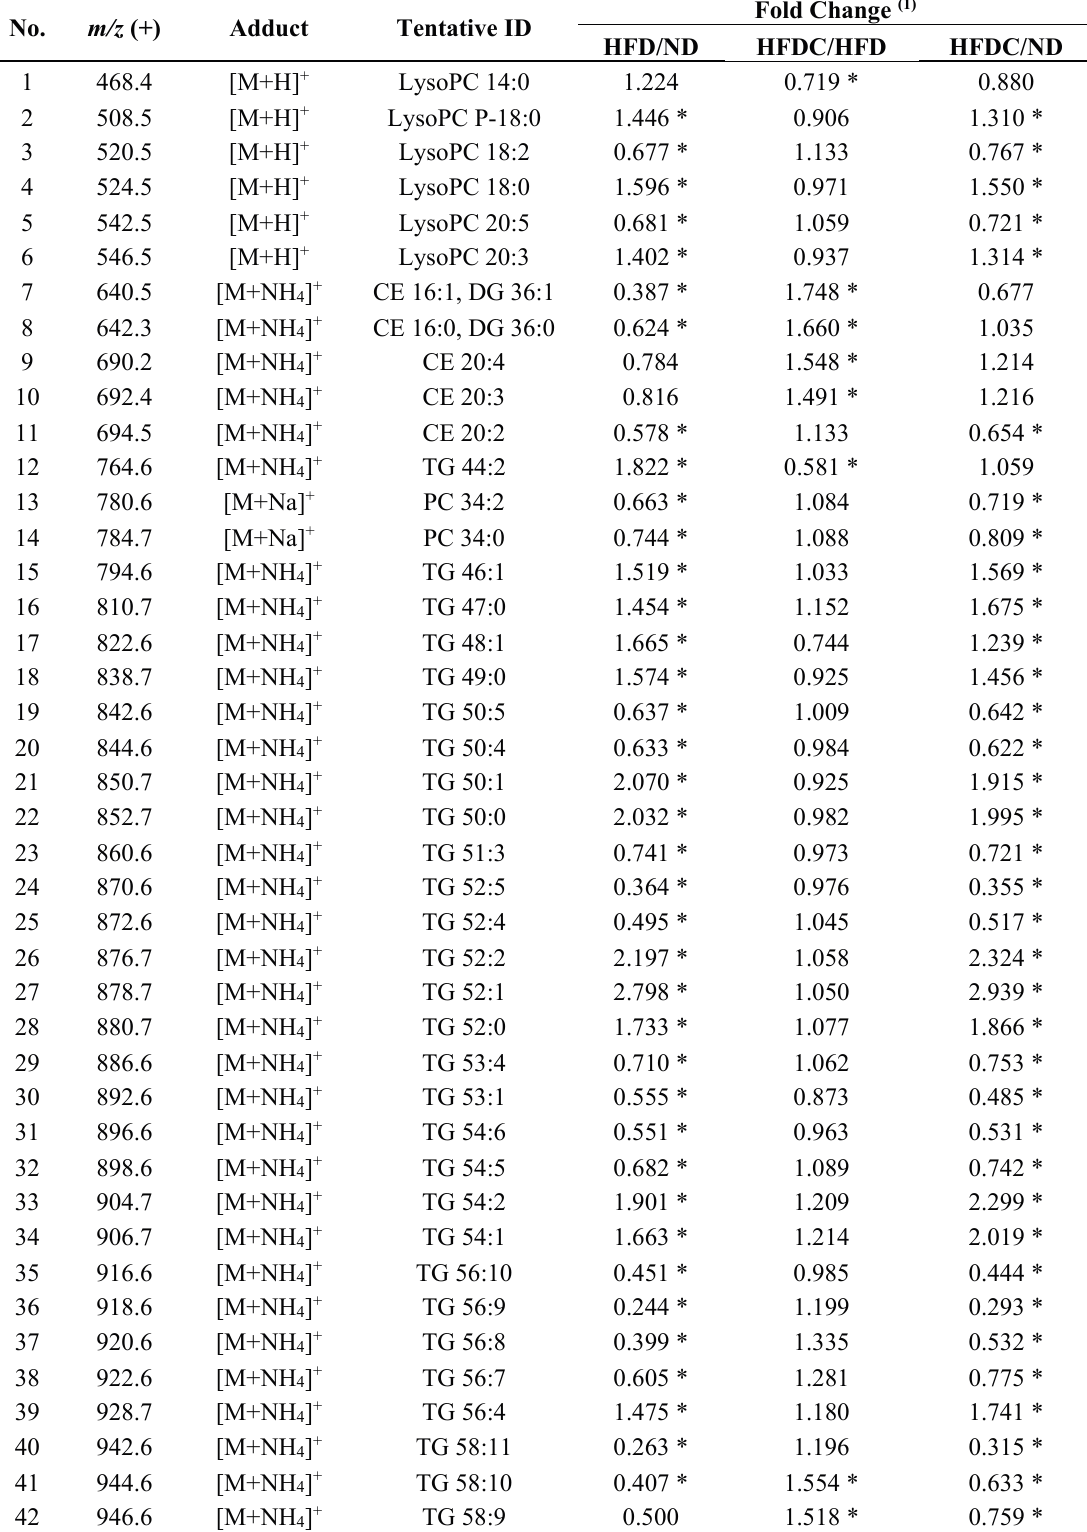
Table 5. Discriminated metabolites of the serum identified using